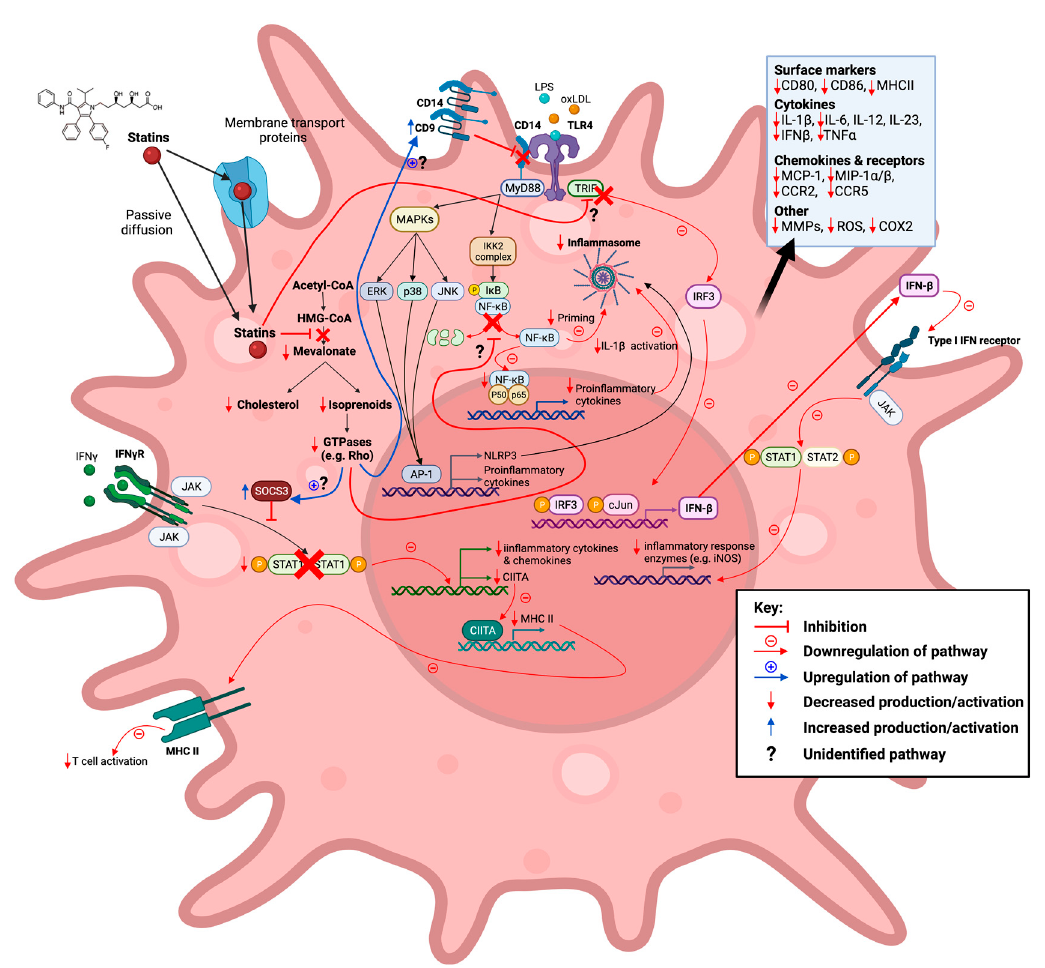
Figure 3. Statins inhibit the mevalonate pathway leading to both reduced cholesterol and isoprenoid biosynthesis, thereby also blocking farnesylation and geranylgeranylation of GTPases. Reduction in these downstream mevalonate intermediates is demonstrated to affect M1-associated macrophage inflammatory signalling pathways in vitro in an anti-inflammatory manner. This action of statins is seen in response to exogenous lipopolysaccharide (LPS), endogenous (interferon gamma (IFN- γ ), and oxidized low-density lipoprotein (oxLDL) ligands. Created with BioRender.com, accessed on 7 March